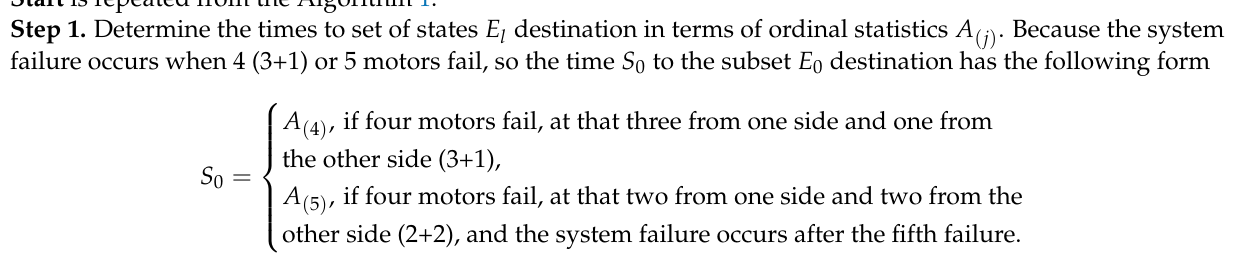
Algorithm 2: The choice of a PM strategy for a heterogeneous system Start is repeated from the Algorithm